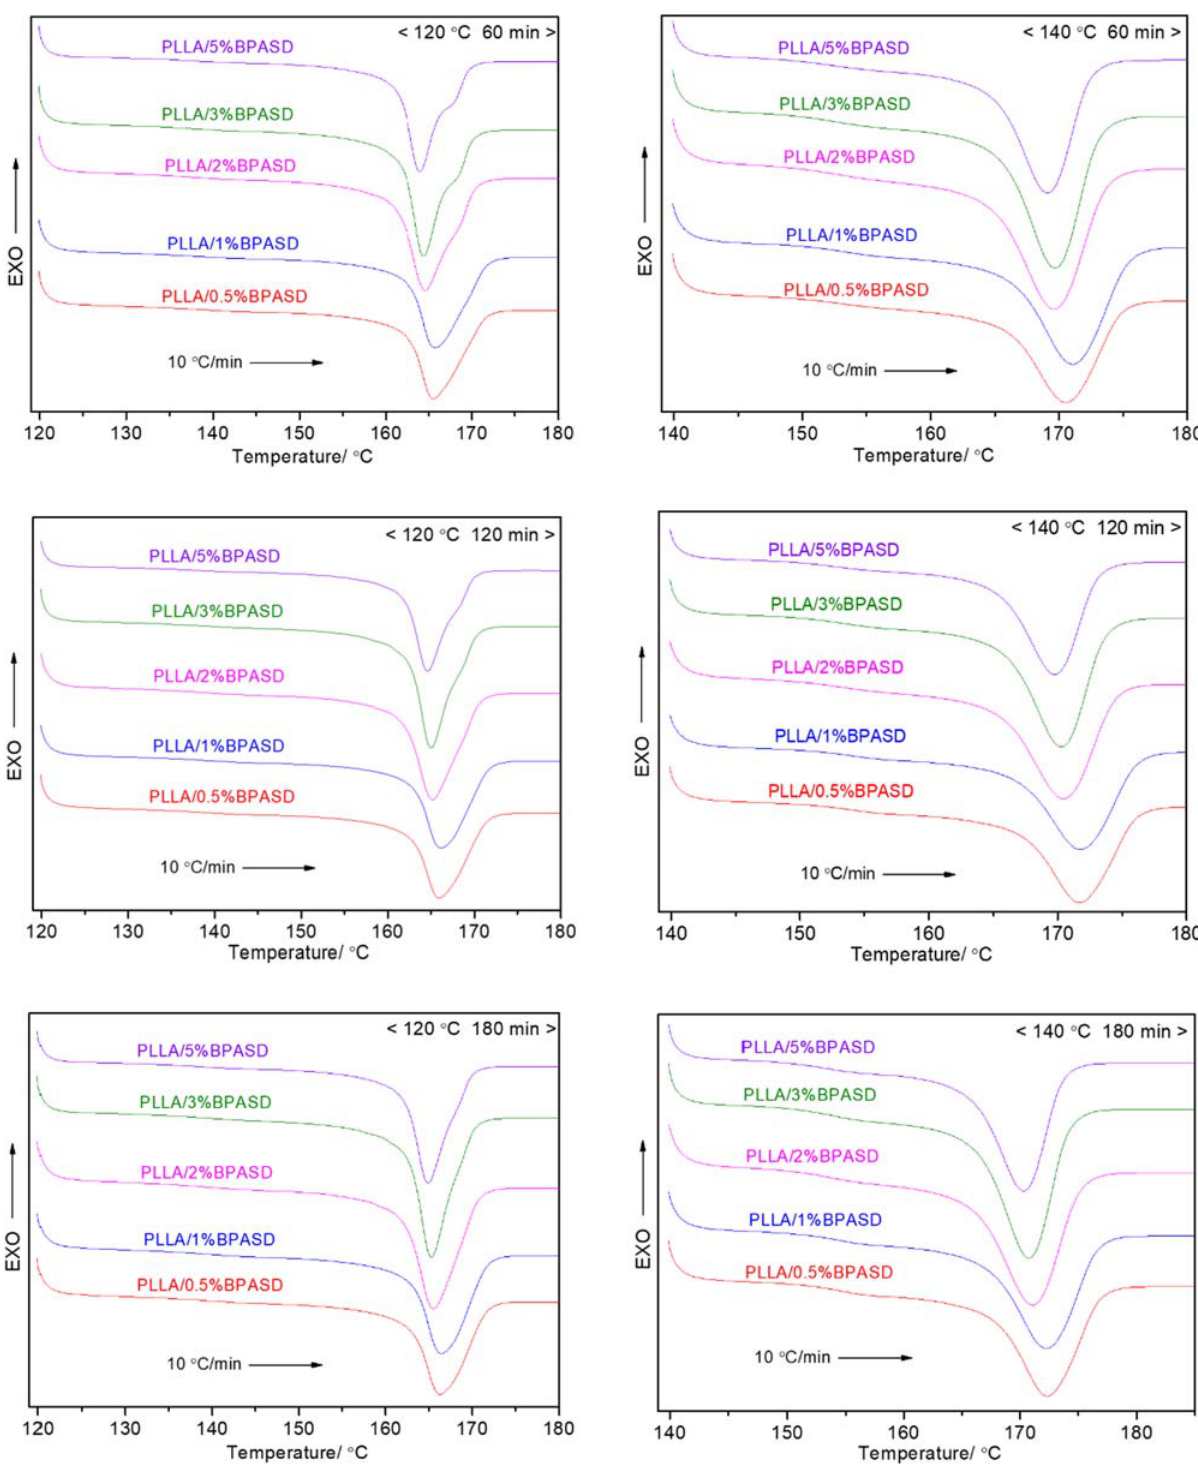
Figure 8: Melting behavior of PLLA/BPASD samples at a heating rate of 10 ℃ /min after isothermal